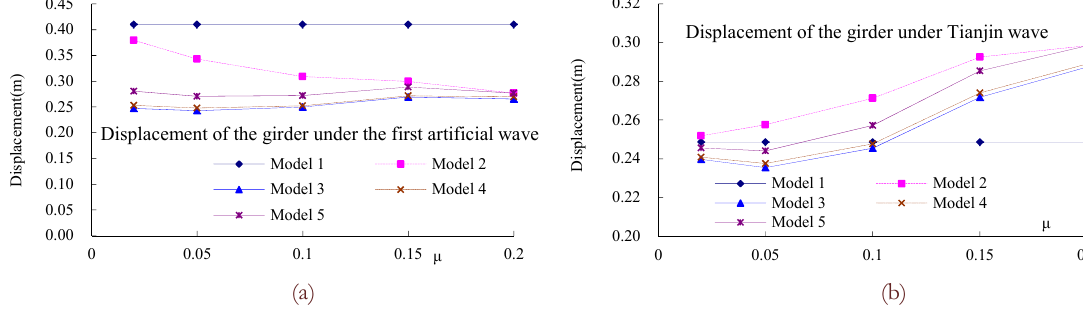
Figure 9: Comparison of displacement of girder in each